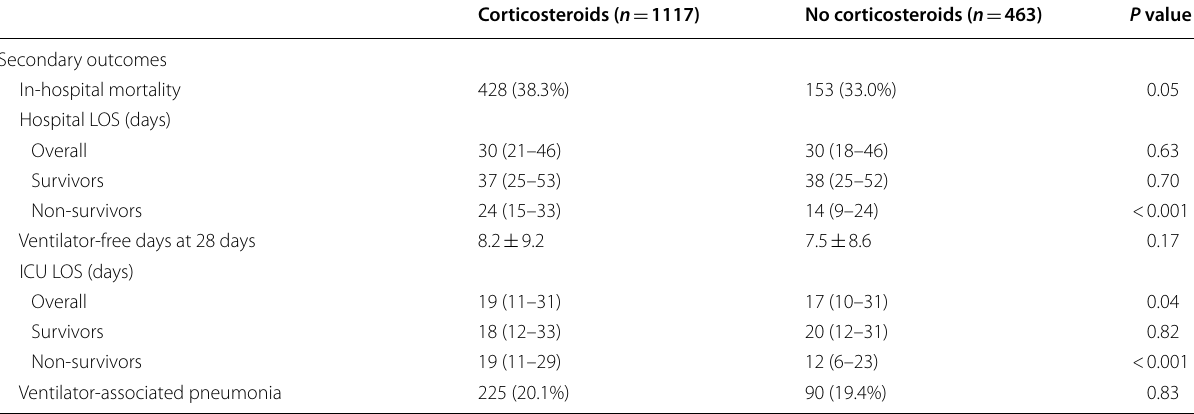
Ventilator-free days are expressed as mean and standard deviation using the Wilcoxon rank sum test with continuity correction. LOS (length of stay) is expressed as medians with interquartile ranges. Ventilator-associated pneumonia incidences are presented as numbers with